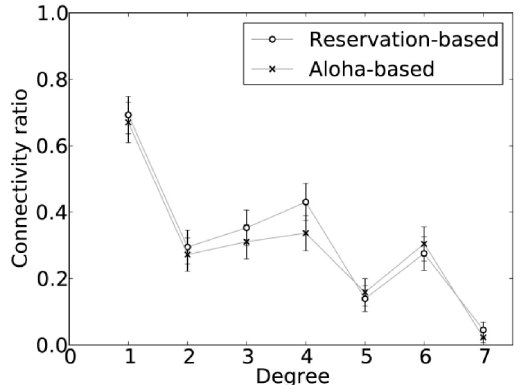
Figure 9. Mean bidirectional link lifetime ratio versus density in simulated environment.